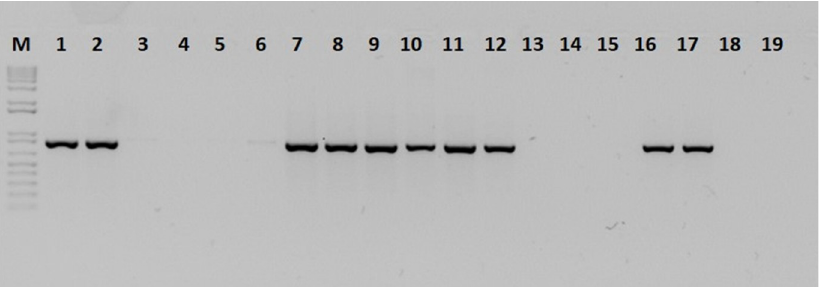
Fig 3. PCR amplification with P11 primers using DNA from rice seeds with different levels of disease severity. M, molecular marker 1 kb plus; 1 to 15, naturally infected rice seeds; 16, DNA B . glumae 3252–8; 17, DNA B . glumae 3252–8; 18, negative control (PCR reaction mix with water); 19, negative control (PCR reaction mix